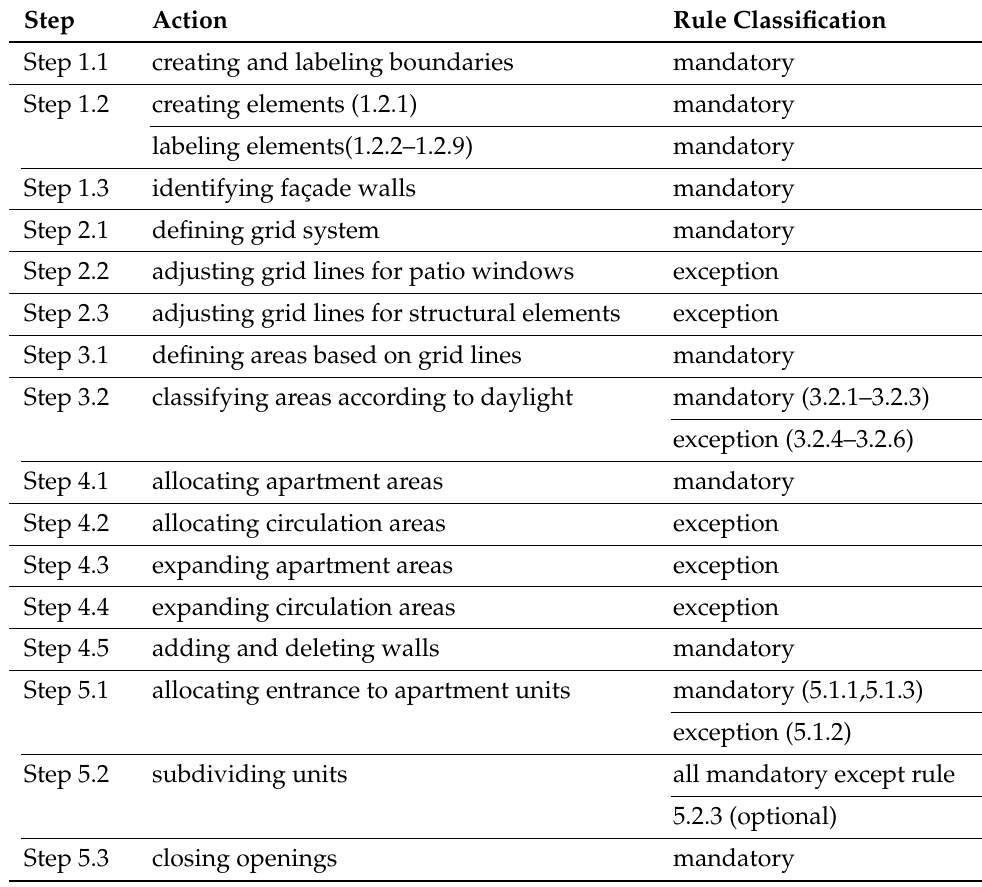
Table 2. Summary of steps and classification of rules according to their application during the derivation